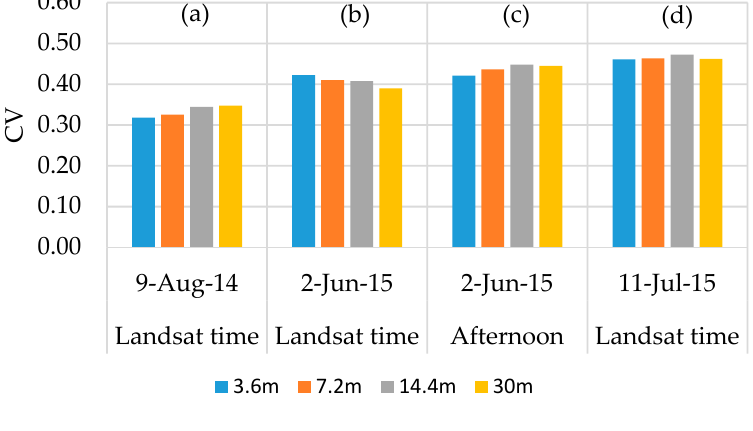
Figure 12. Spatial domain effect on the mean of LE spatial data at different times.